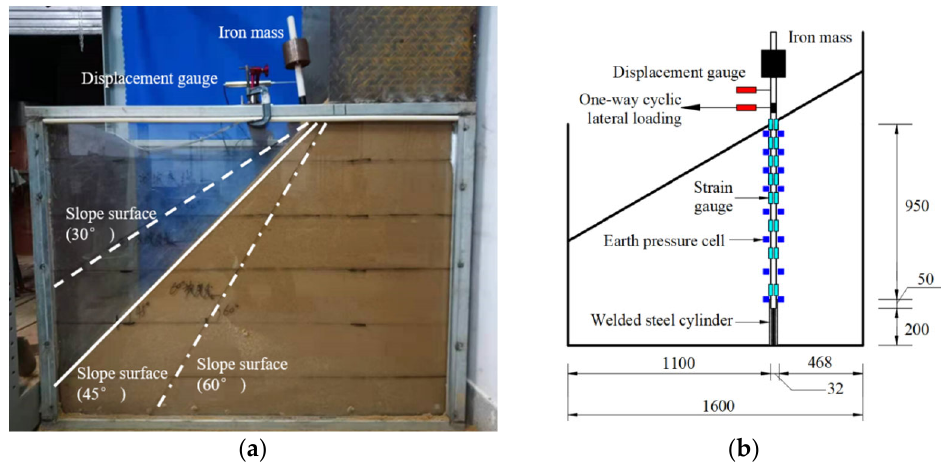
Figure 1. Experimental setup. ( a ) model pile and slope; ( b ) geometric dimension.